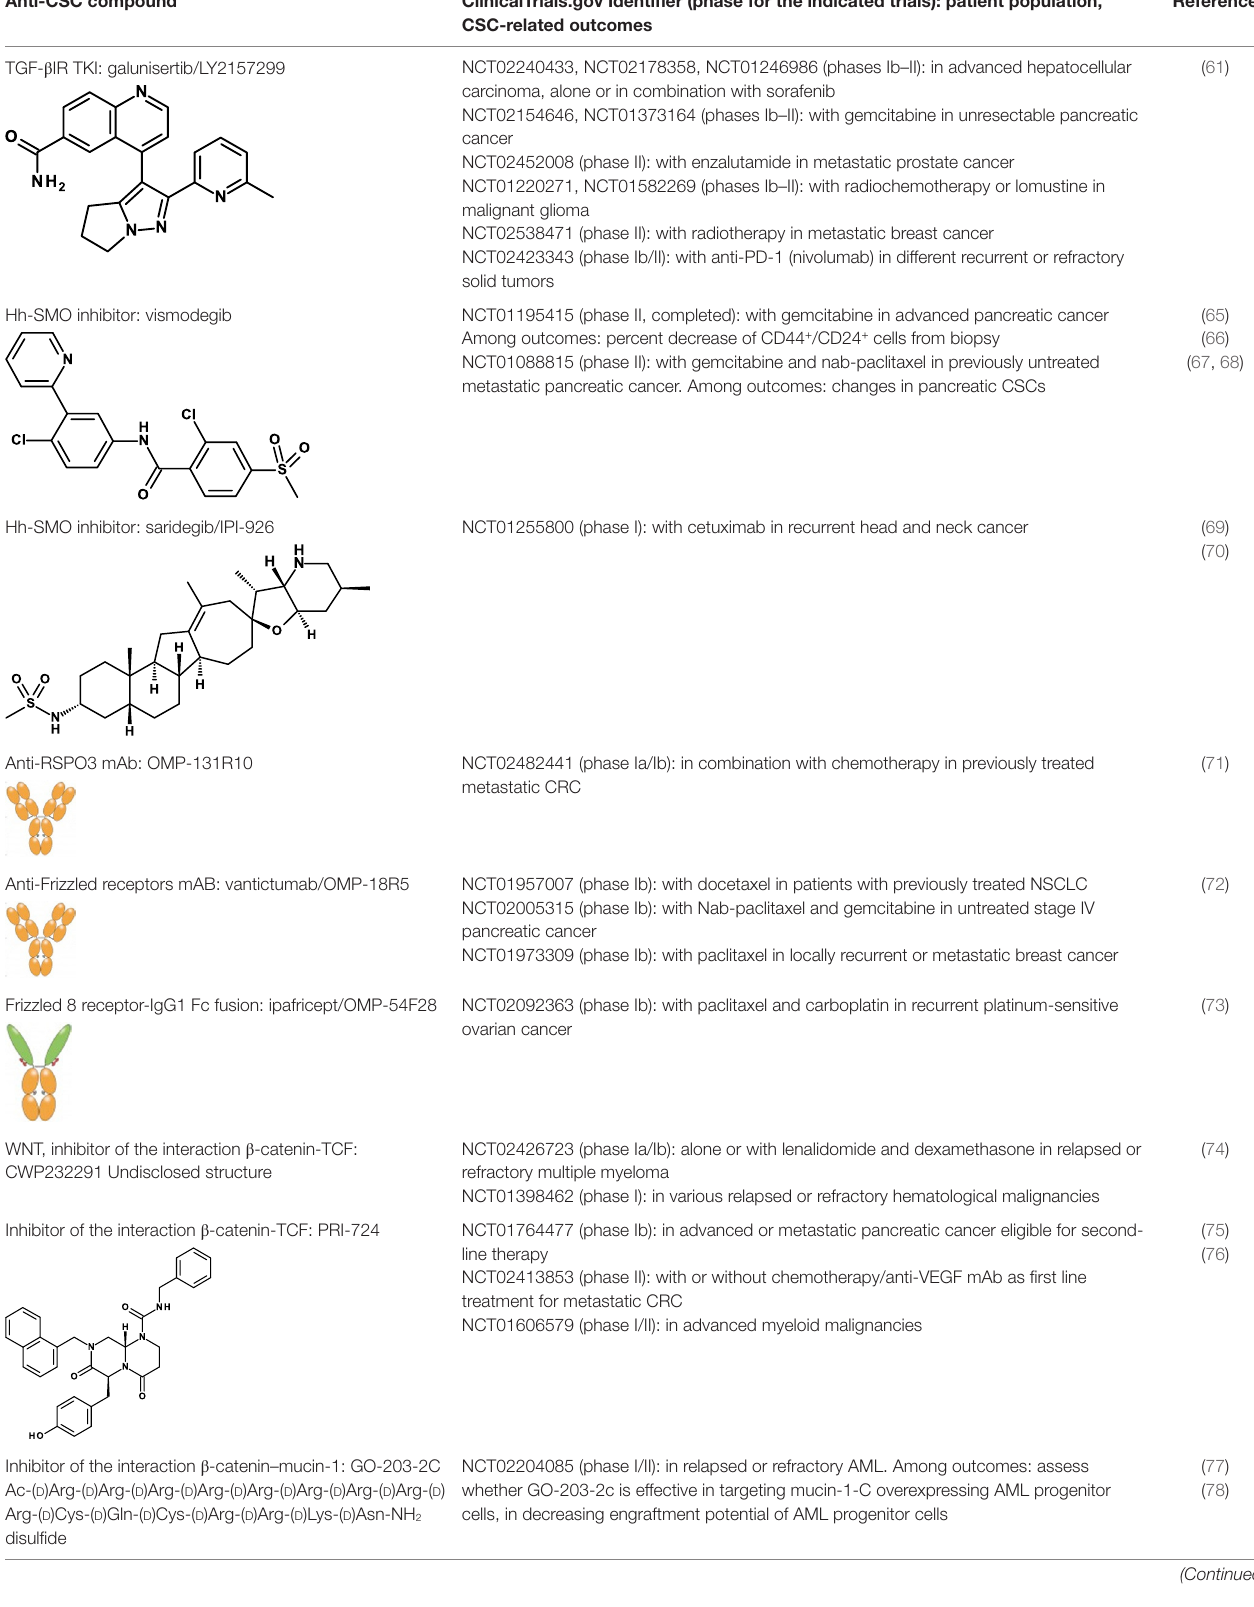
TABLe 2 | Anti-CSC compounds that act on ligand–receptor pairs and their signaling pathways. Anti-CSC